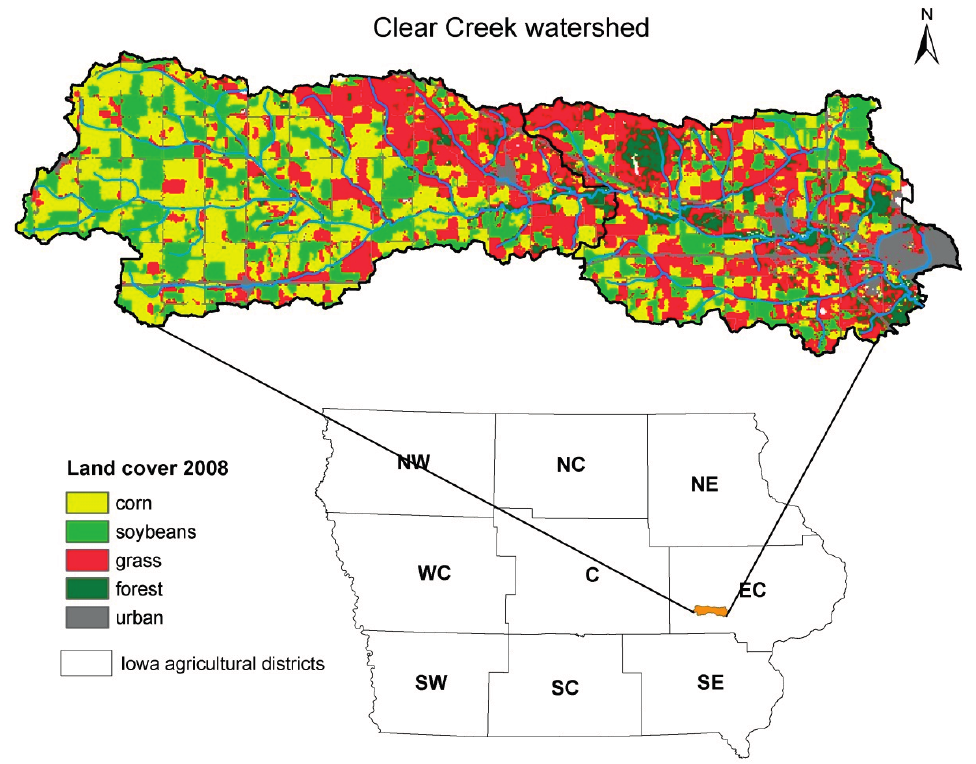
Figure 1. The Clear Creek Watershed in East-Central